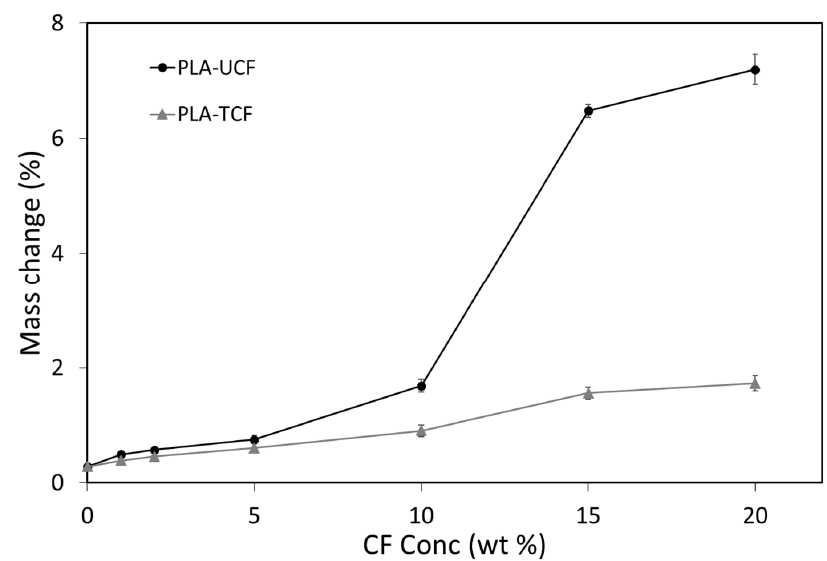
Figure 4. Water absorption behaviour of the films with varying CF concentration.